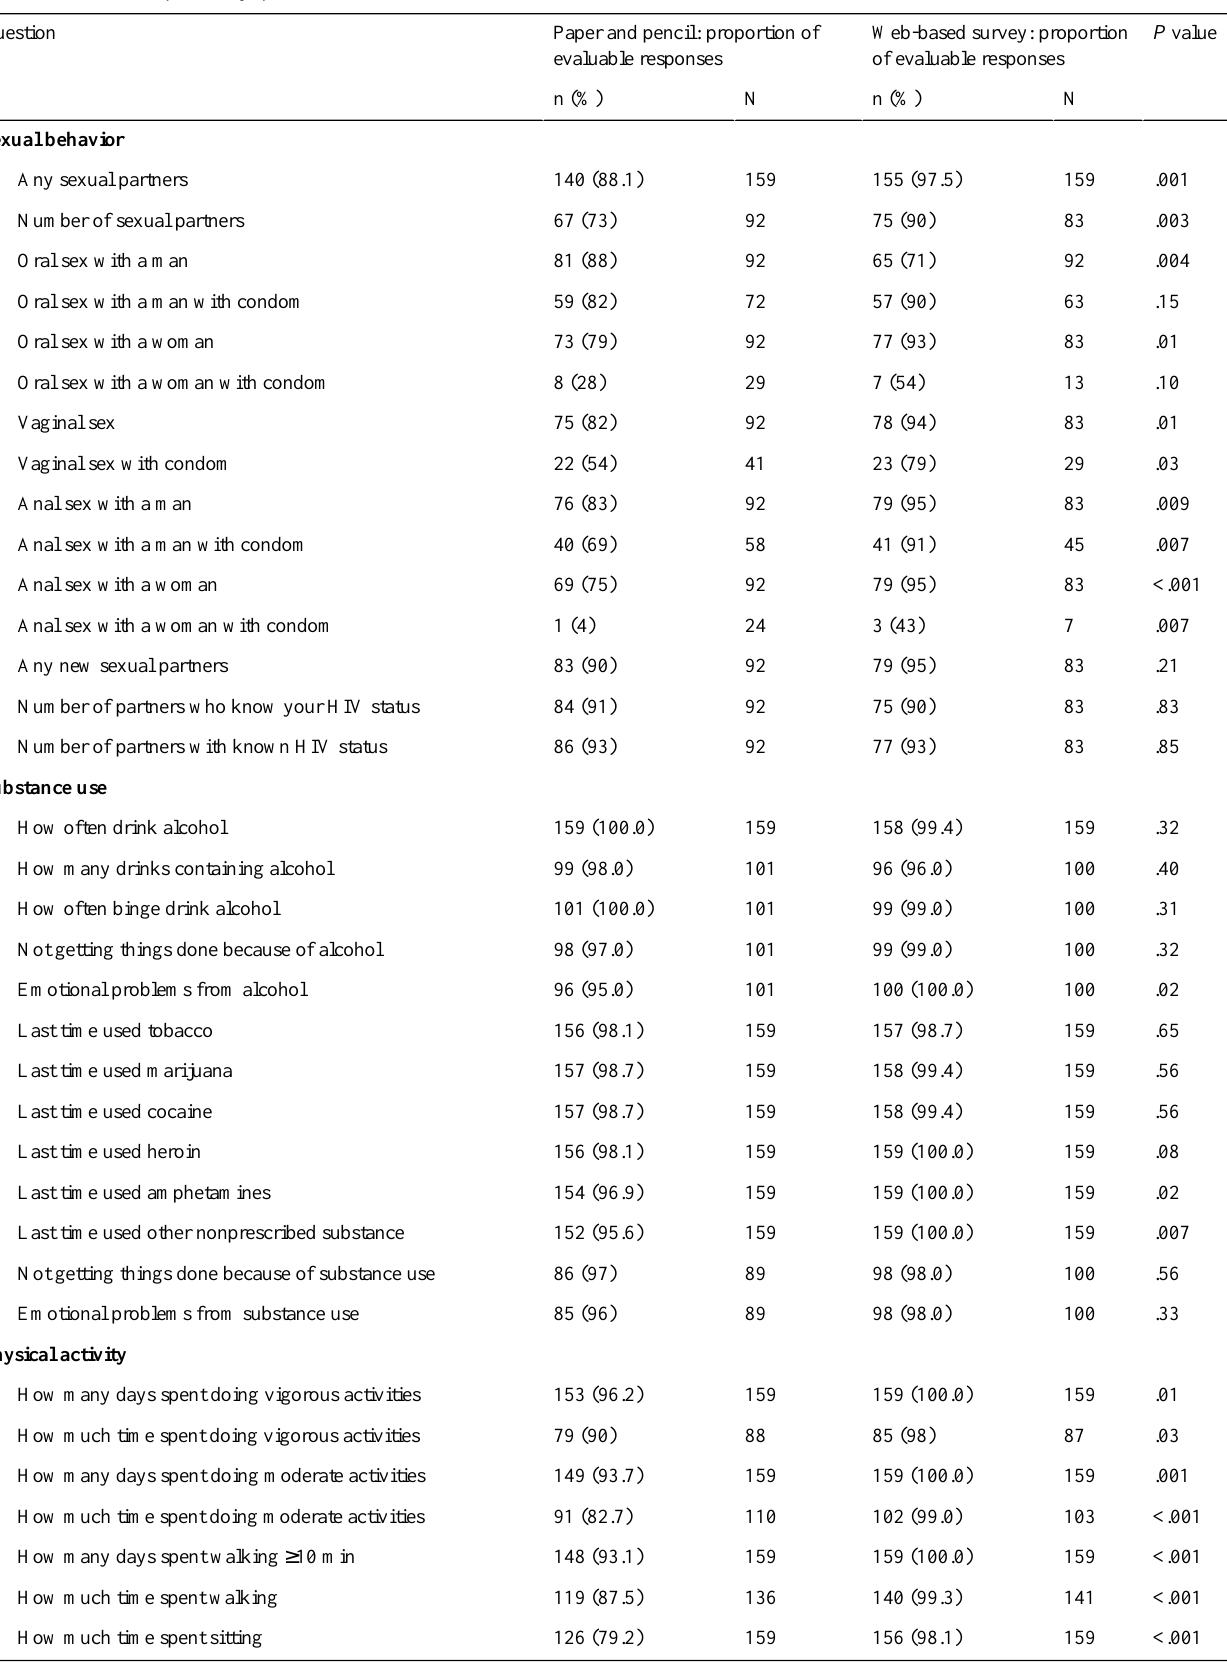
Table 5. Evaluable responses by questionnaire format (N=159).